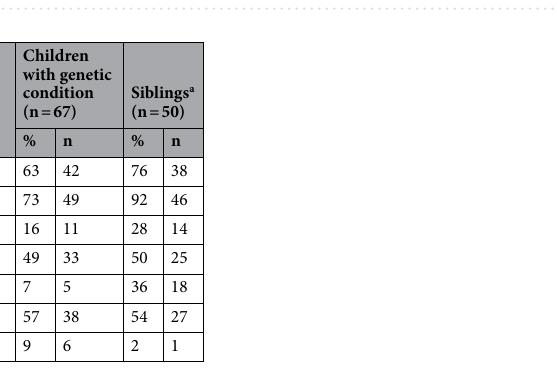
Table 4. Details of disclosed information. Note all items were multiple-choice answers. a This number reflects the number of respondents who answered that they had disclosed information to the siblings of affected children in questionnaire